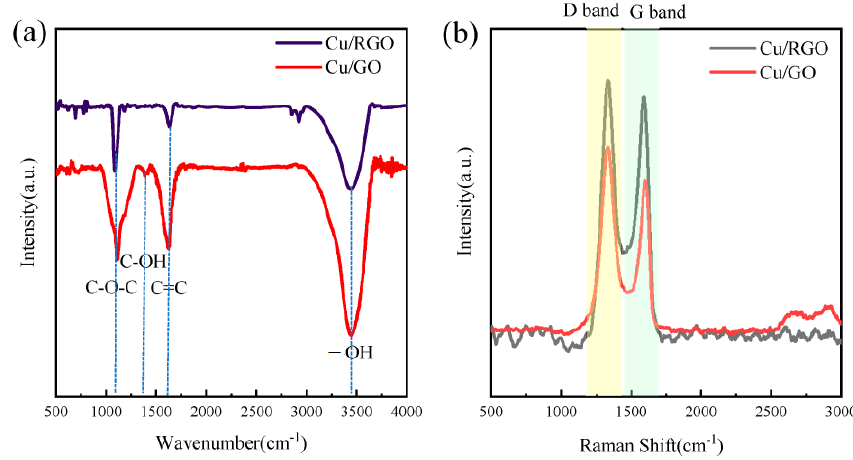
Figure 3. Fourier infrared spectrum ( a ) and Raman spectrum of the sample ( b ) of Cu/GO and Cu/RGO composite powders.